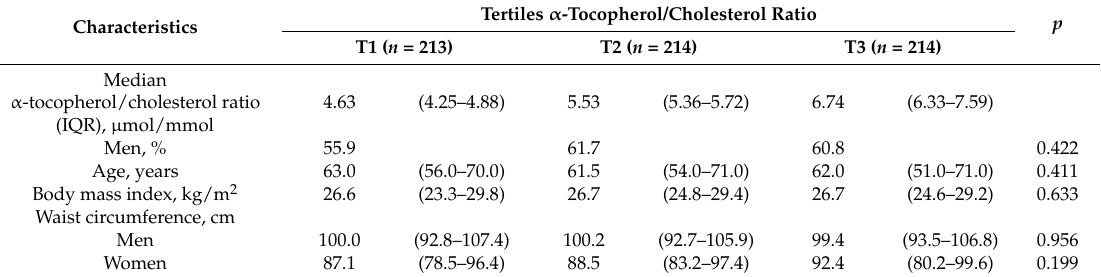
Table 1. General characteristics of the PopGen control study population ( n = 641) according to tertiles (T) of α -tocopherol/cholesterol